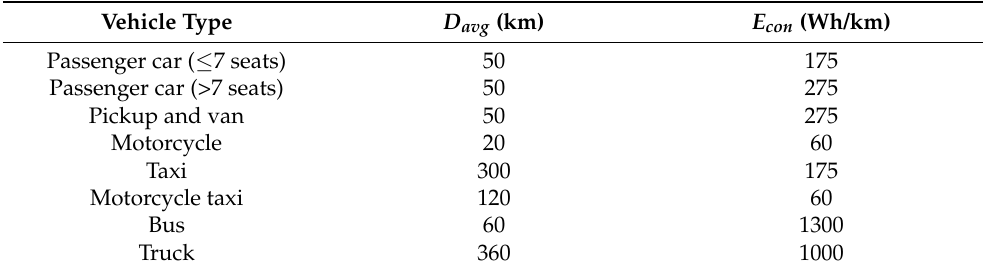
Table 2. Parameters for energy consumption estimation.